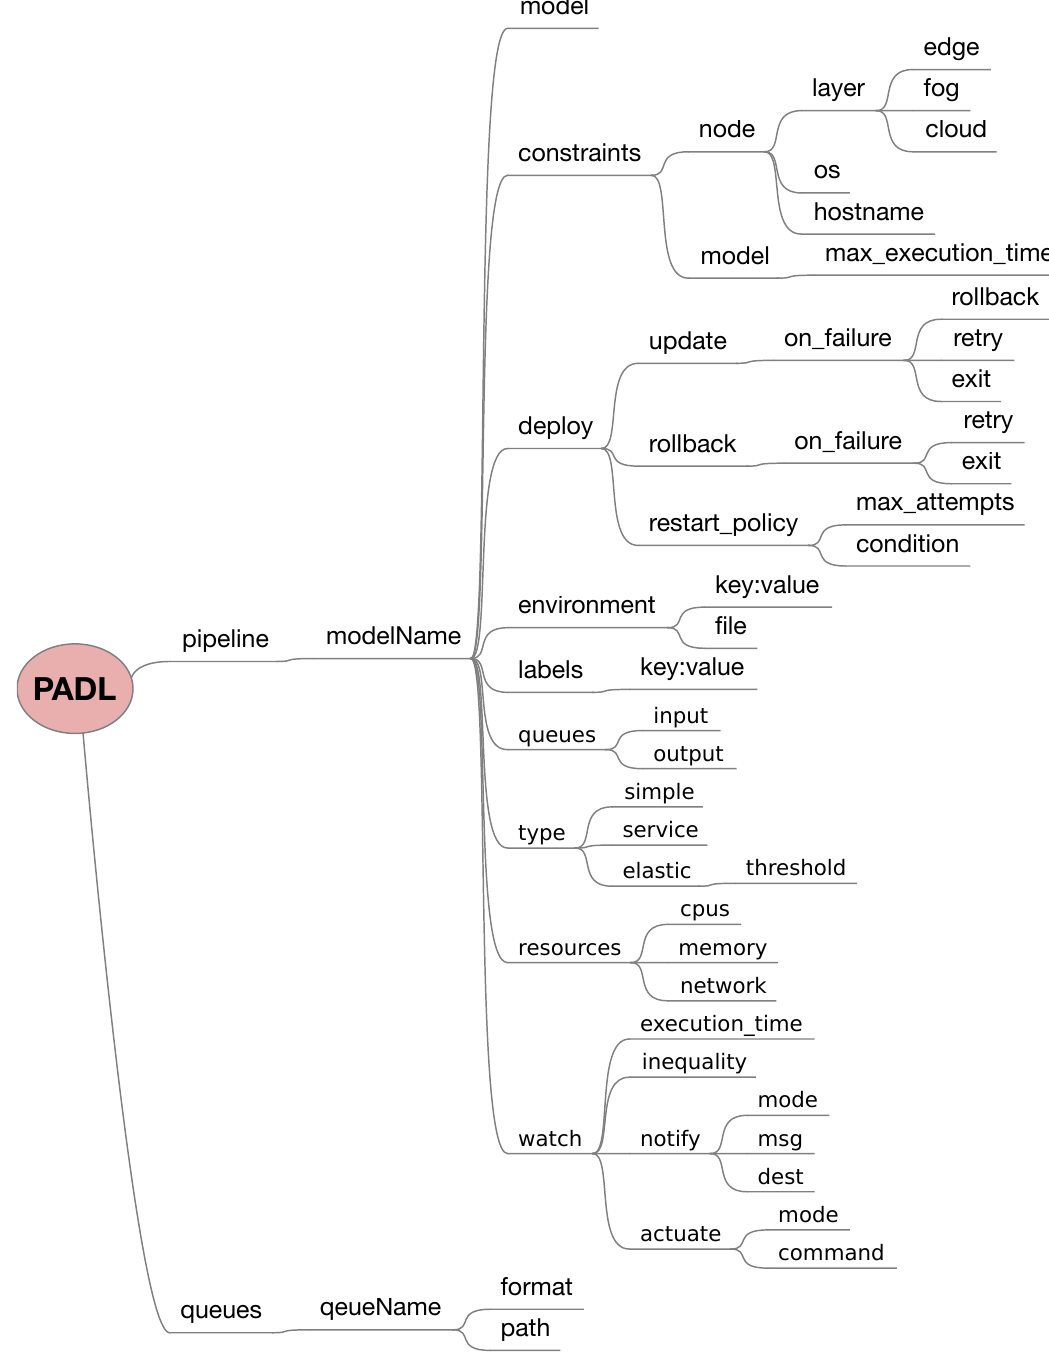
Figure 6. Tree diagram showing the PADL